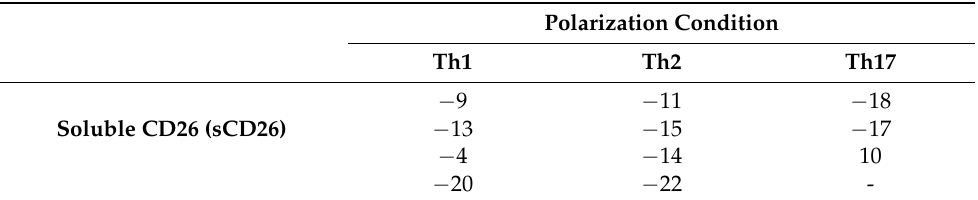
Figure 7. Each bar shows the mean ± SD of ng mL − 1 /3 × 10 6 cells cultured for 3 days in the following conditions: Th0 (no polarization), Th1, Th2, and Th17 ( n = 4 or more for each condition). Table 1 shows, however, that the levels, if compared with the Th0 counterpart in each experiment, were usually lower in the secretomes of polarized cells. Table 1. Differences in culture medium sCD26 levels after T lymphocyte polarization with respect to nonpolarizing activation conditions in four donors